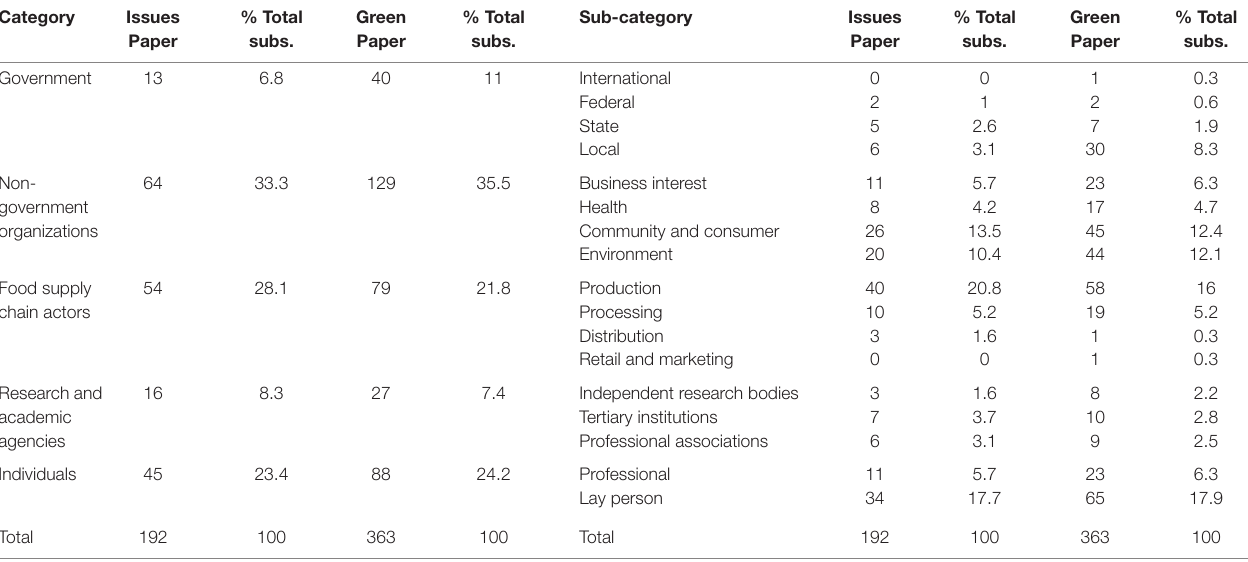
TaBle 1 | number and frequency of written submissions per category and